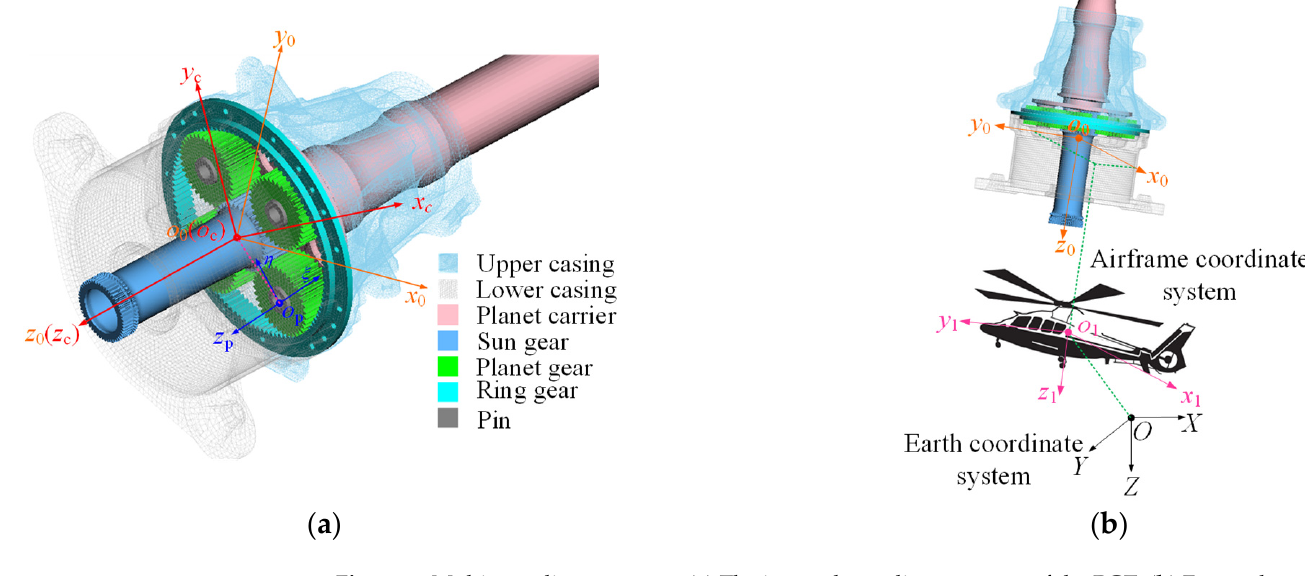
Figure 3. Multi-coordinate system. ( a ) The internal coordinate system of the PGT; ( b ) External coor- dinate system.